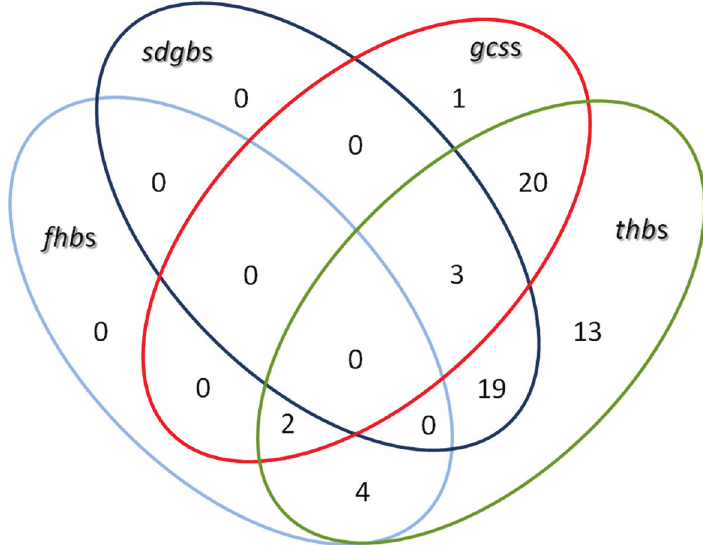
Figure 1. Venn diagram illustrating the distribution of glb genes in the rhizobial bacteria analyzed in this work. Numbers correspond to rhizobial genomes containing glb s.